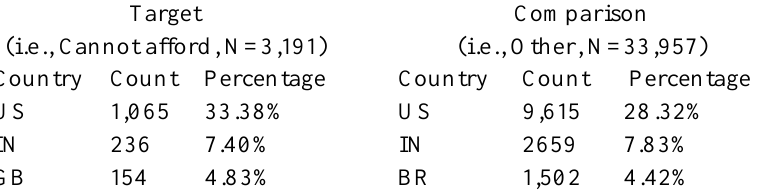
*Country of Origin, Count and Percentage of Enrollment for Learners in the Target vs. Comparison